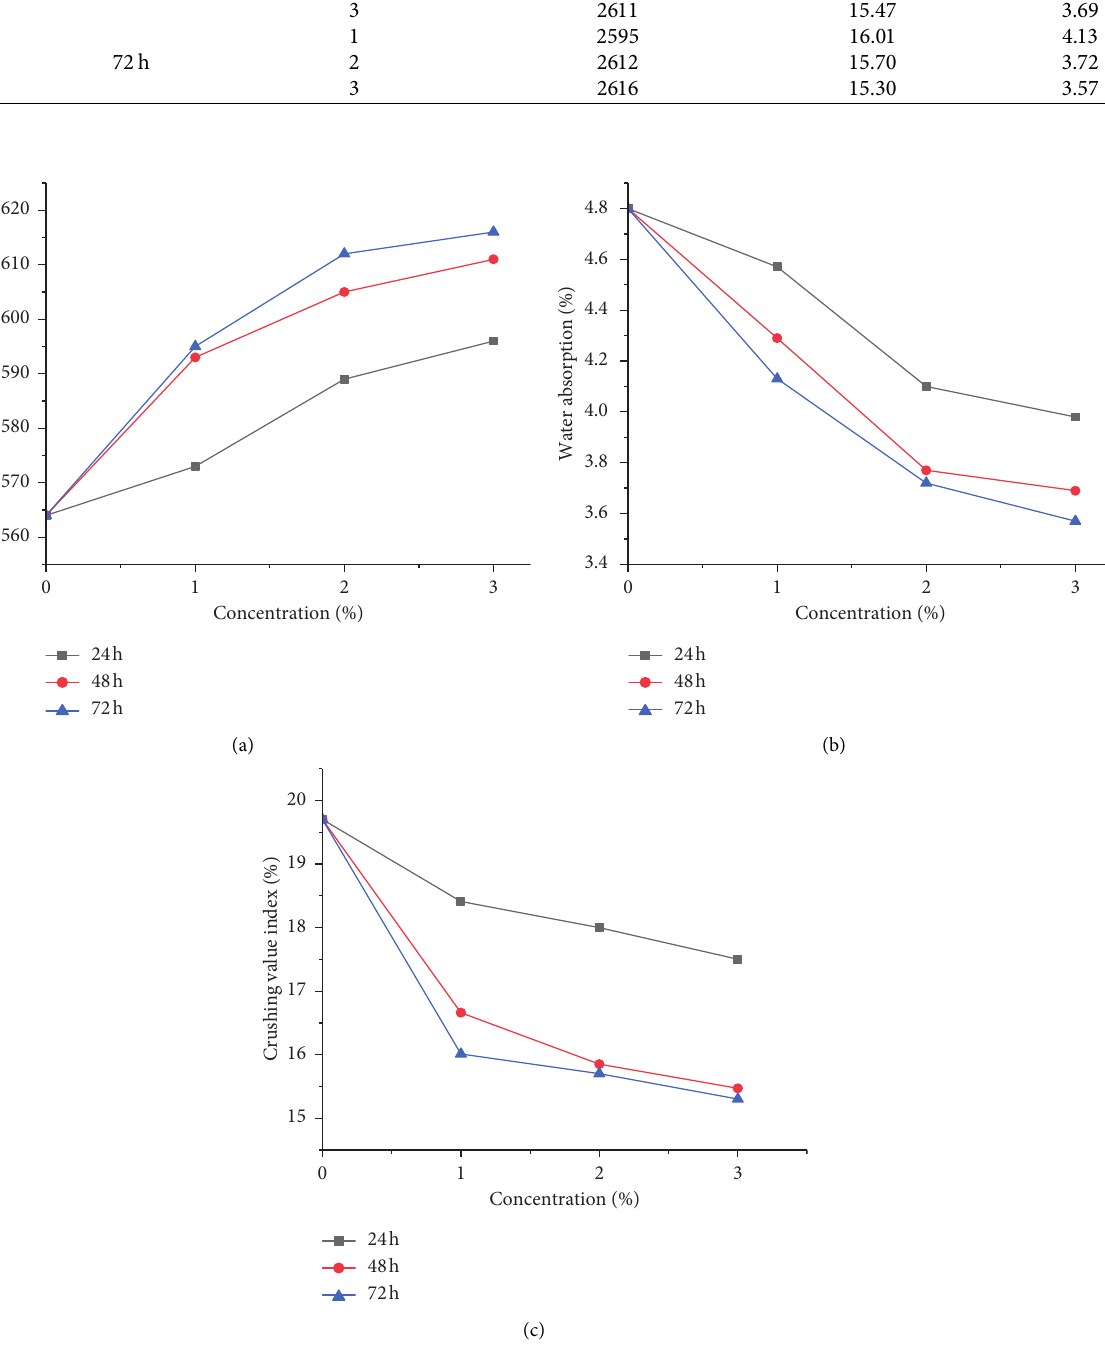
Figure 1: Physical properties of the RA after